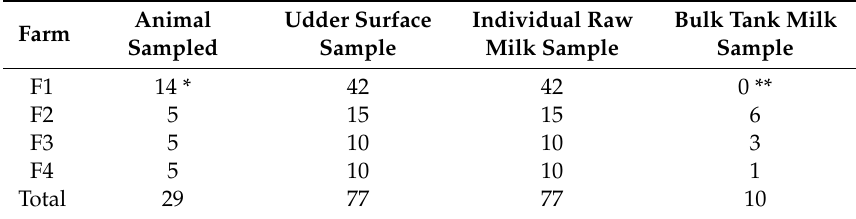
Table 2. Number of samples collected from each